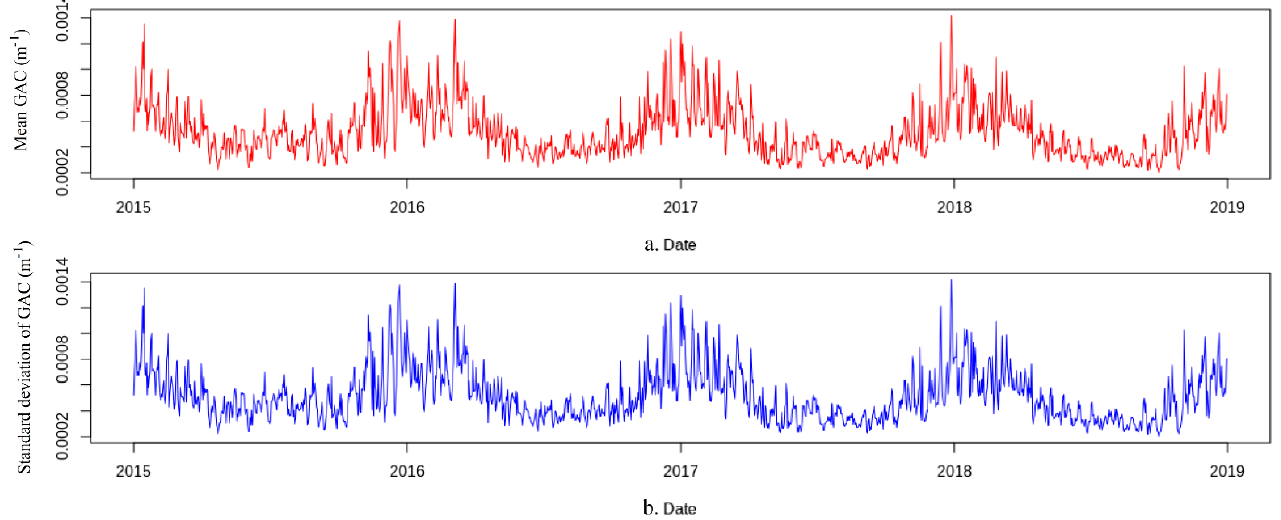
Figure 7. Time series of the mean (a) and standard deviation (b) of AOD in mainland China for 2015–2018.